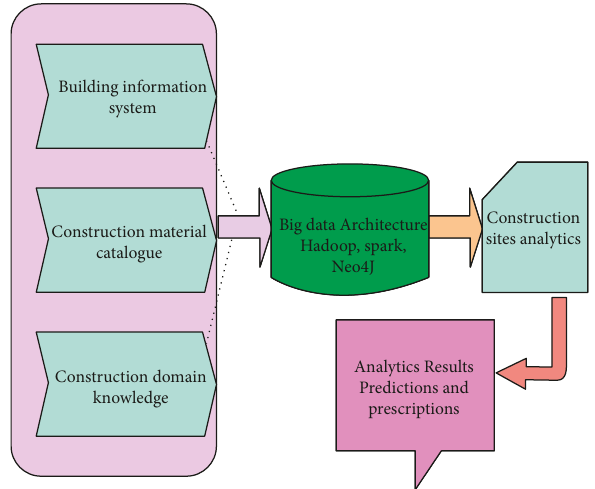
Figure 15: Big data in the construction